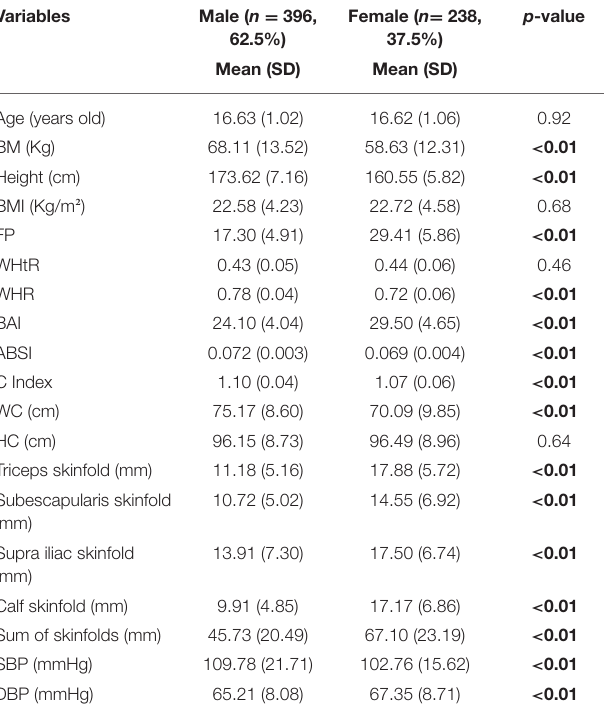
TABLE 1 | General characterization of the sample ( n José, SC, Brazil, 2019.